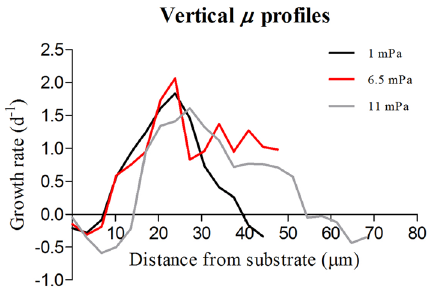
Figure 2. Vertical profile of growth rate in the biofilms formed by C. vulgaris grown at three hydrodynamic shears: 1.0, 6.5 and 11.0 mPa. The growth rate for each layer was calculated as the slope of the linear regression between the coverage of cells in each layer over time. The data are reported as the mean of at least three independent biological replicates (n ≥